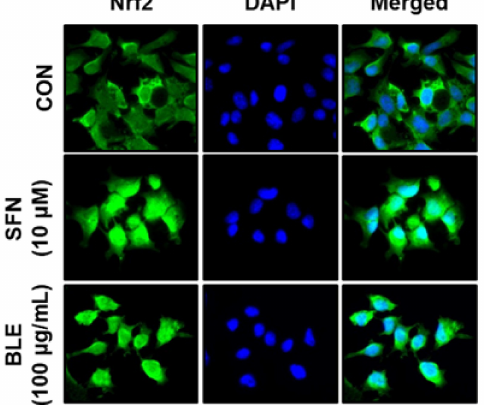
Figure 4. Effects of BLE on activation of Nrf2 in AML12 cells. Cells were treated with the indicated concentrations of BLE or sulforaphane (SFN) for 6 h, and endogenous Nrf2 was detected by indirect immunofluorescence staining with anti-Nrf2 antibody ( × 400 magnification).